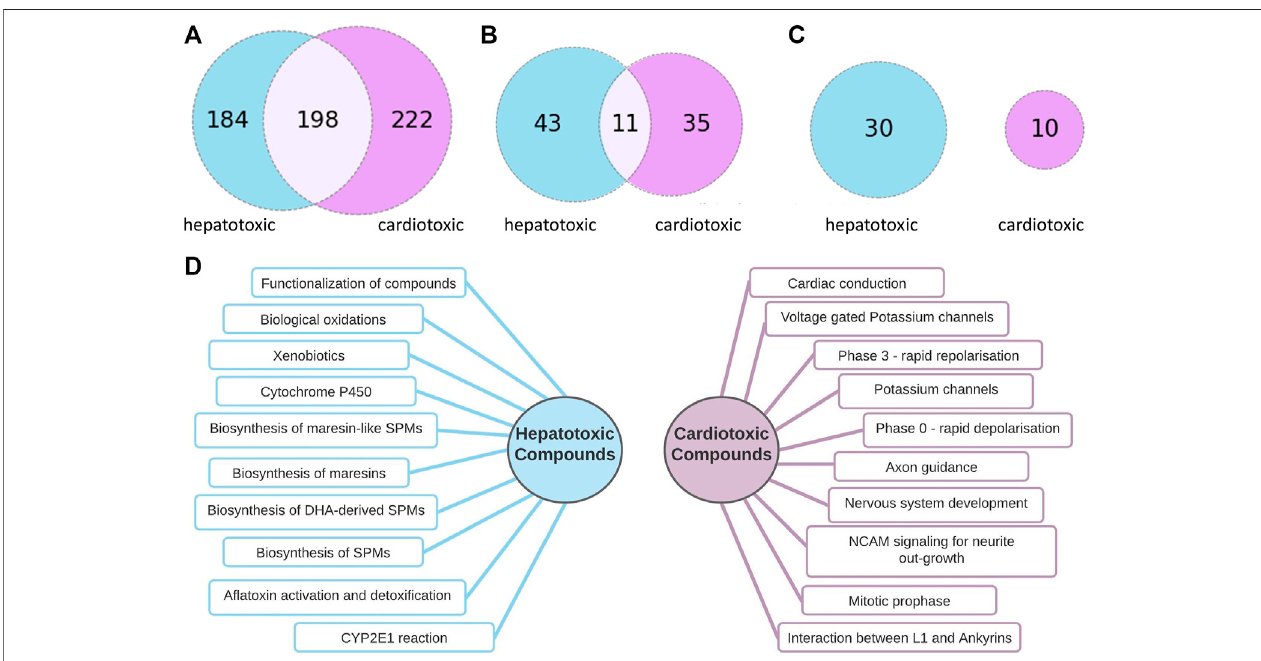
FIGURE 3 | Comparison of pathways connected to hepatotoxic and cardiotoxic drugs (A) : Number of pathway connections with an FDR cut-off of 0.05 of the hepatotoxic (blue) and cardiotoxic (purple) group, (B) : Number of pathways affected by at least 10% of hepatotoxic (blue) and at least 10 % of cardiotoxic (purple) compounds, 11 common pathways (C) : Number of pathways affected by at least 20% of hepatotoxic (blue) and at least 20 % of cardiotoxic (purple) compounds, no common pathways (D) : 10 of the most often occurring pathways connected to hepatotoxic (left) and to cardiotoxic (right)